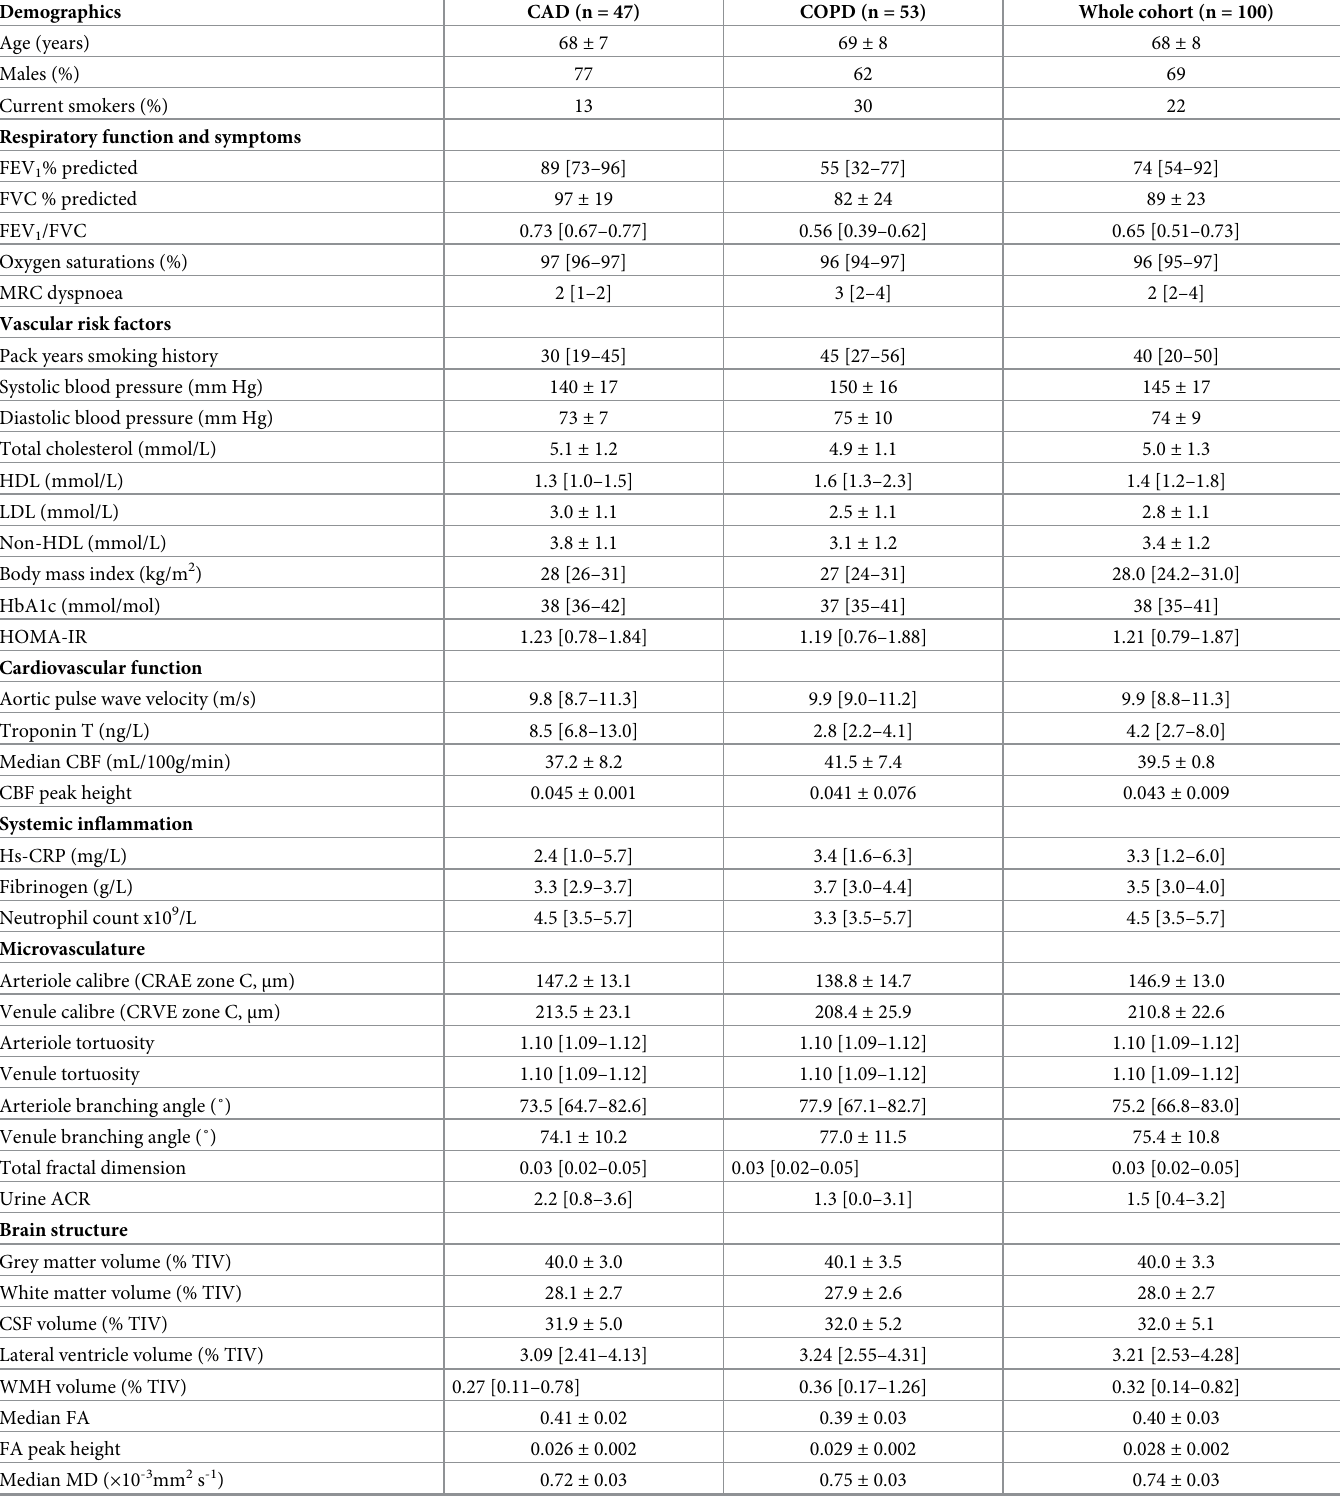
Table 1. Demographics and clinical